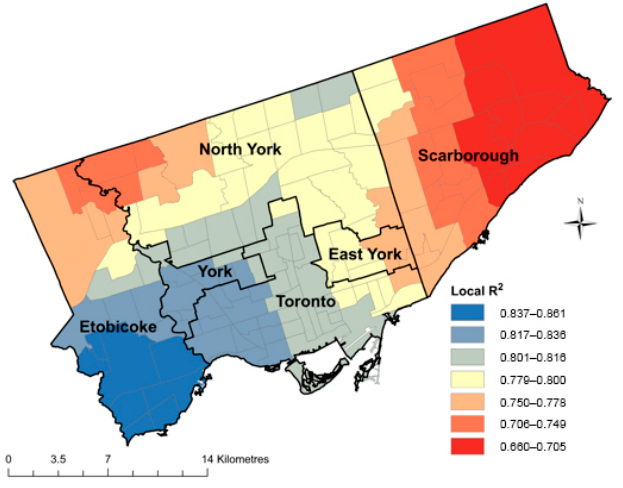
Figure 3. Distribution of adjusted local R 2 in GWR model for property crime.